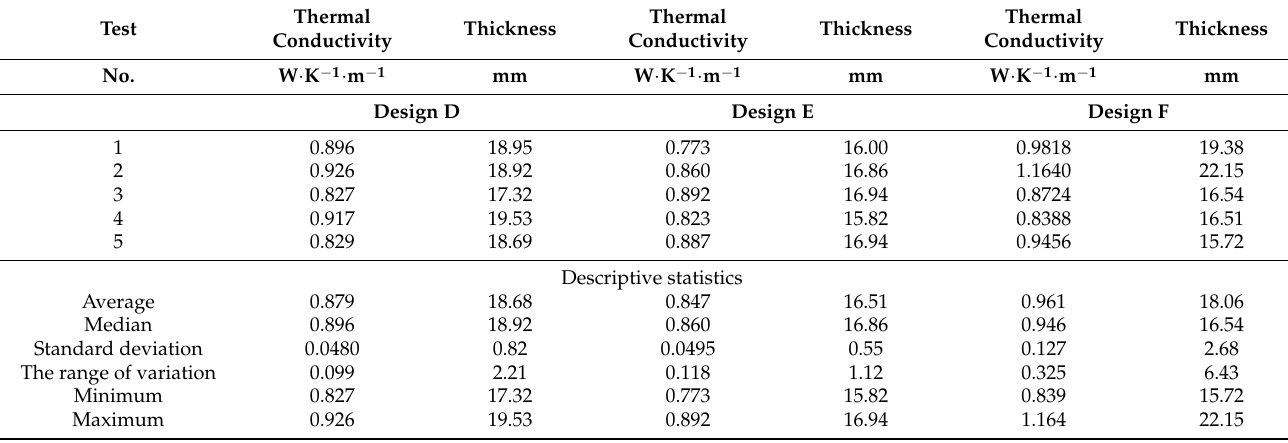
Table 5. Thermal conductivity test results for designs D, E and